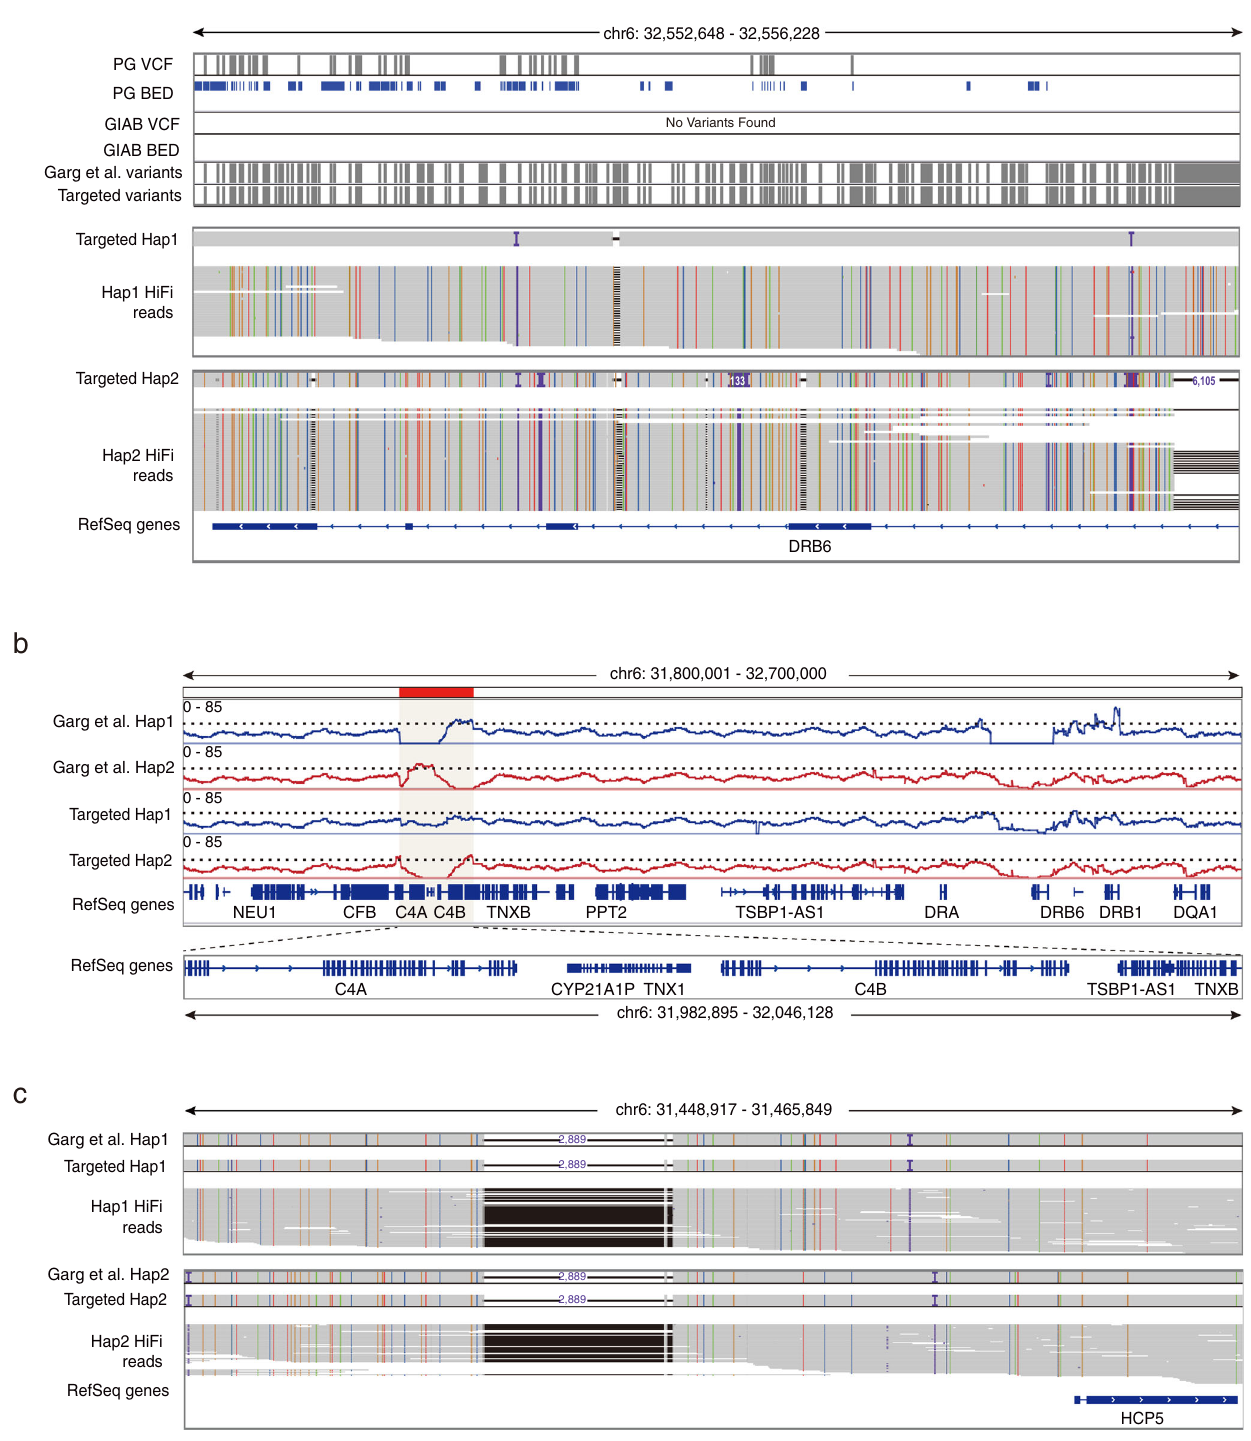
Fig. 3 | Accurate genetic variant calling using the targeted haplotype-resolved assembly.a Anexampleofaregionwithnewlyidenti fi edvariants.High-con fi dence HiFi reads with new variants are illustrated below. The colorful lines and dots positioned in the targeted assembly result of the haplotype 1 and HiFi reads indi- cate four types of nucleotides different from the hg38 reference. The purple character “ I ” and dots indicate small insertions (<50bp) compared to the hg38 reference. Black dots indicate small deletions (<50bp) compared to the hg38 reference. PG: the Illumina Platinum Genomes. b Collapsed region in the